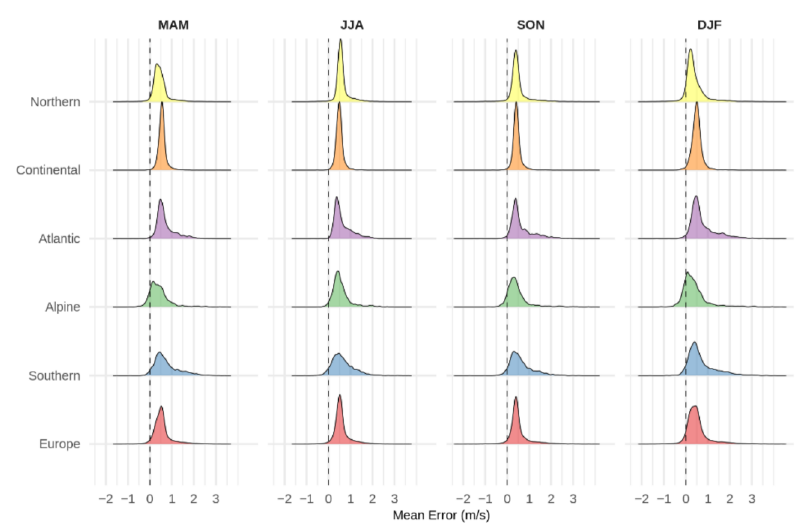
Figure 7. ME distributions of unadjusted ECMWF SEAS5 ensemble seasonal forecasts of 10-m wind speed (one-month lead time) for European sub-regions and whole domain. ME was computed with respect to ERA5 over